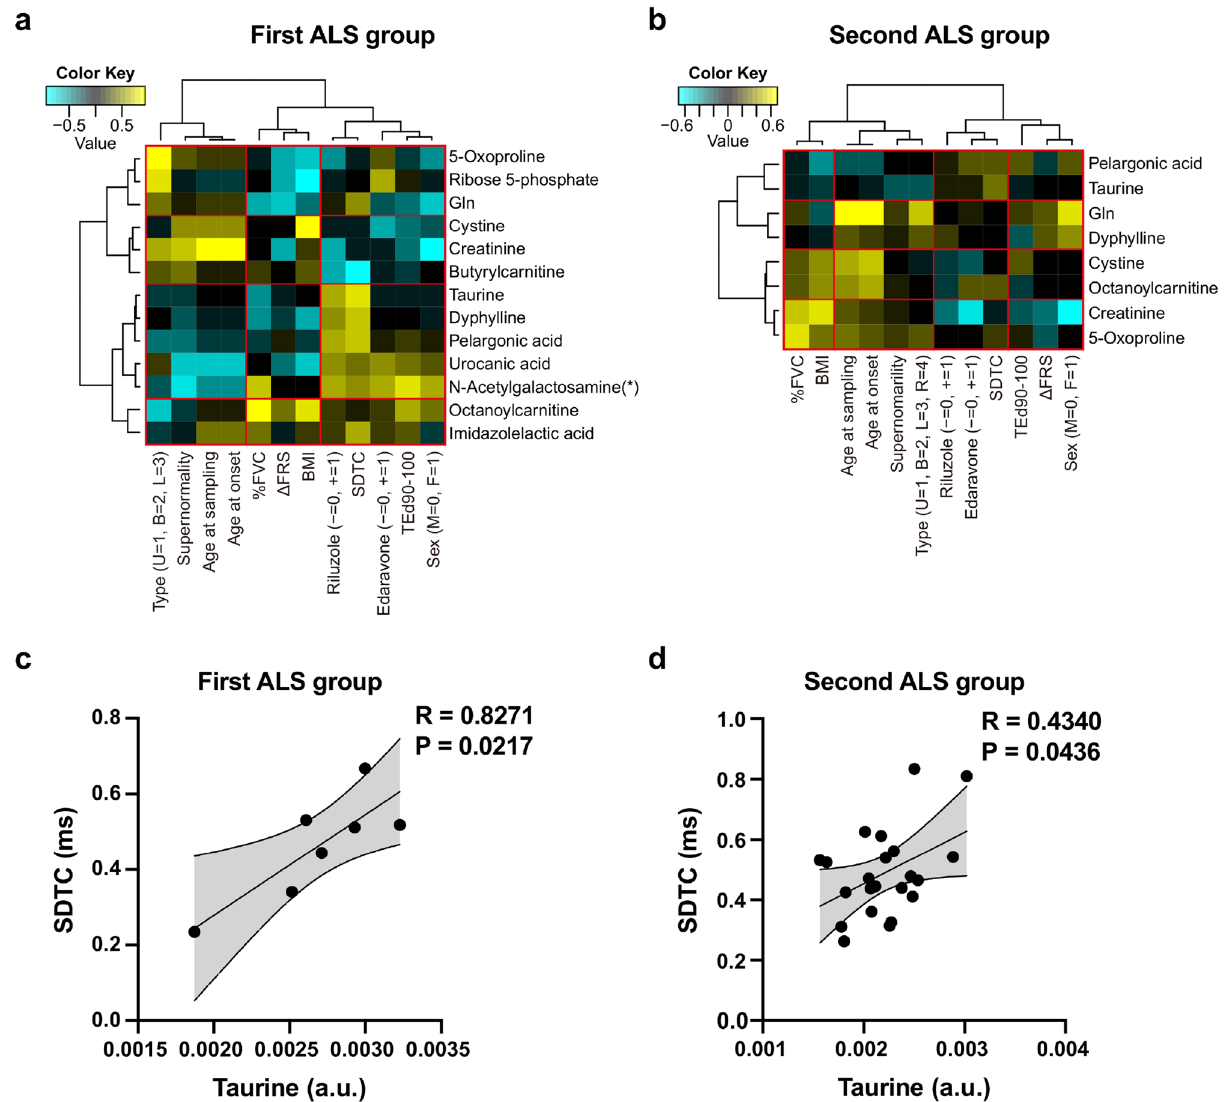
Figure 2. ( a , b ) Hierarchical clustering analysis with heatmap representation of the metabolites and the clinical parameters of ( a ) the first amyotrophic lateral sclerosis (ALS) group and ( b ) the second ALS group. Rows indicate ( a ) 13 metabolites with statistical significance between the control and first ALS group and ( b ) a subset of the 13 metabolites detected in the second ALS group. The N-acetylgalactosamine(*) row includes N-acetylmannosamine and N-acetylglucosamine. 3-Methoxytyrosine, 7-methylguanine, N-acetylputrescine, and N6-acetyllysine were excluded from the dataset because the four metabolites had a distribution along a vertical line, and thus no correlation coefficient was available. Columns indicate the 12 clinical parameters assessed in the study. ( a , b ) The heatmap shows a gradient color scale ranging from cyan to black to yellow, indicating the normalized score (Z-score) calculated from Spearman’s rank correlation coefficient for each combination. ( c , d ) Correlation analysis between taurine and nerve excitability properties (SDTC) in both groups of ALS patients. Scatterplots show the correlation between taurine and SDTC in the ( c ) first ALS group (n = 7) and ( d ) second ALS group (n = 22). Pearson’s correlation coefficient (R) and the p-value ( p ) are shown. a.u. arbitrary unit, BMI body mass index, FA fatty acid, %FVC percent forced vital capacity, SDTC strength duration time constant; sex ( M male, F female), T2DM type 2 diabetes mellitus, Ted depolarizing threshold electrotonus; treatment with Riluzole and/or Edaravone (− negative/non-administration, + positive/ administration); type = site of symptom onset ( U upper limbs, B bulbar, L lower limbs, R respiratory failure), ΔFRS progression rate (ratio of Functional Rating Scale score to